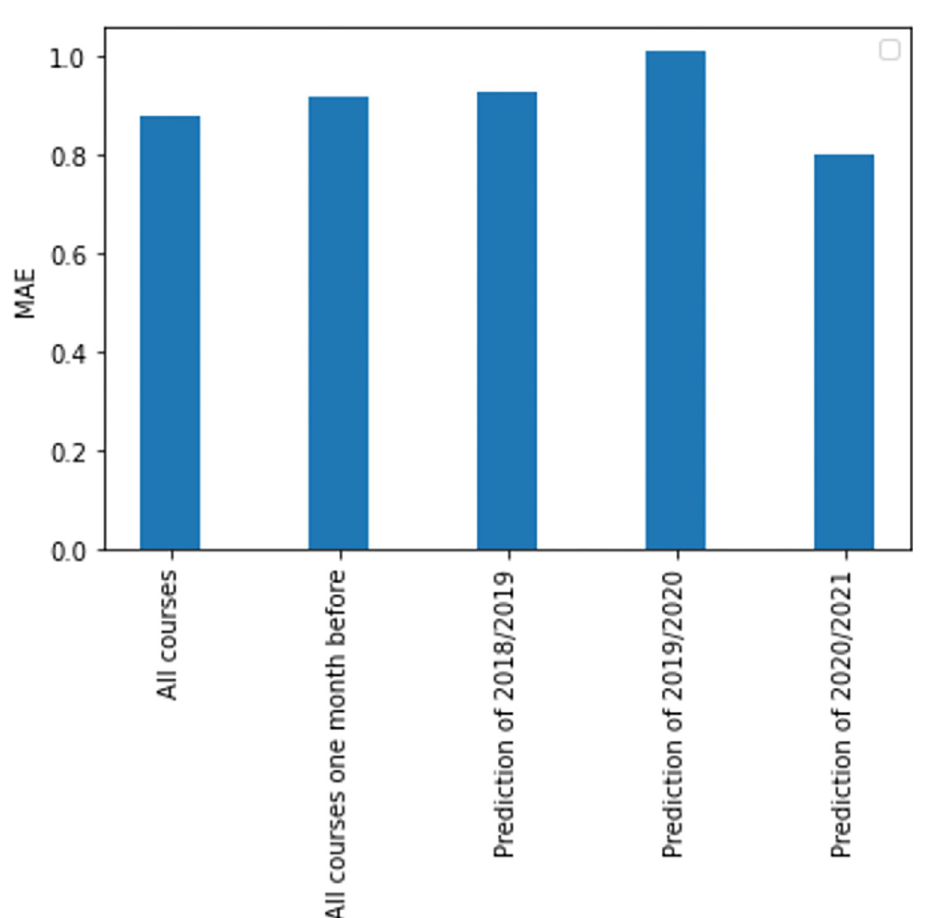
Fig 5. Summary of MAE results in the